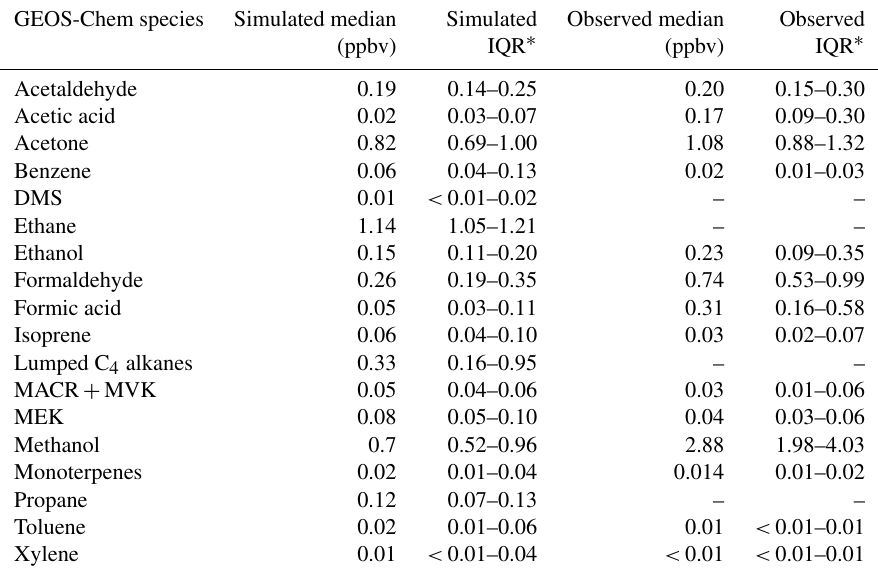
Table 3. Statistics of VOCs included in GEOS-Chem along with the corresponding observations at TFS. Blank entries for observed VOCs indicated that the VOC was either not detected by the PTR-ToF or was below detection